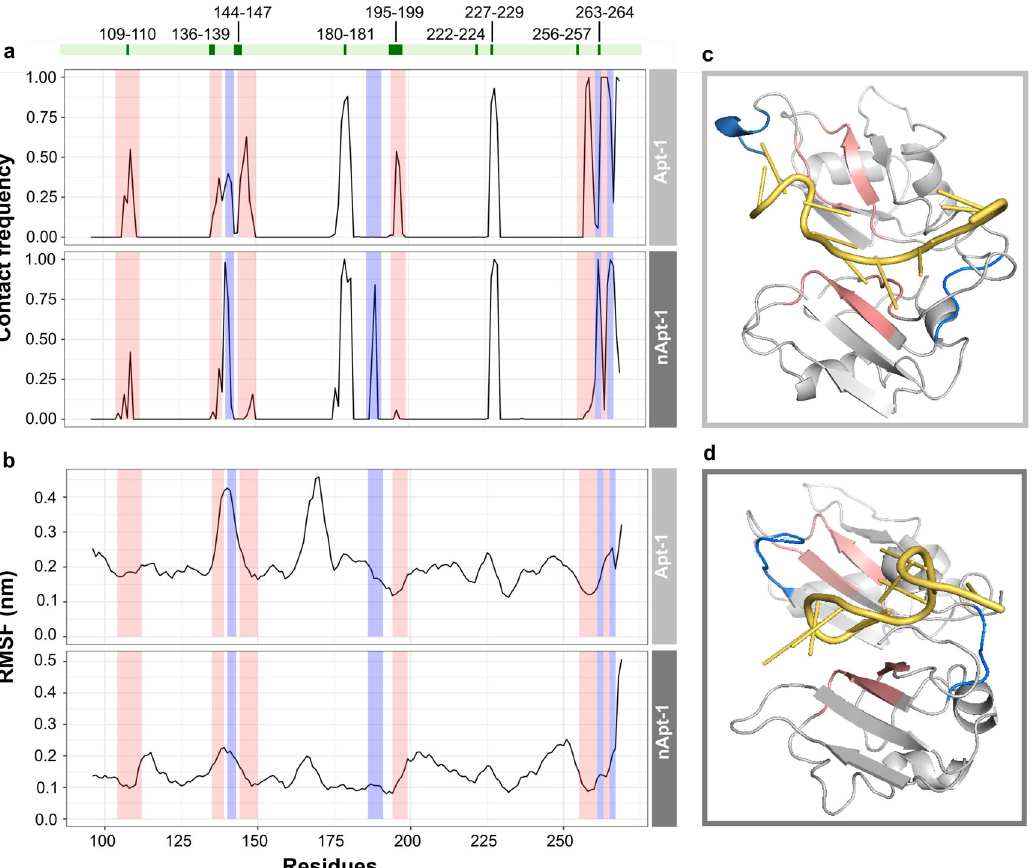
Fig. 3 MD characterization of Apt-1 and nApt-1 interactions with RRM1-2. a Contact frequency computed along Apt-1 and nApt-1 MD trajectories; the contacts observed in the NMR model structure are marked with green boxes at the top of the image. Red is used to indicate contacts more frequent for Apt-1 and blue contacts that are more frequent for nApt-1. b Root mean square fl uctuation computed along Apt-1 and nApt-1 MD trajectories. The color of the boxes follows the same as in panel ( a ). c Structural representation of residues with stable contacts in complex with Apt-1 (RRM1-2 representative con fi guration at equilibrium shown; colors correspond to panels ( a ) and ( b ). d Structural representation of residues with stable contacts in complex with Apt-1 (RRM1-2 representative con fi guration at equilibrium shown; colors correspond to panels ( a ) and ( b